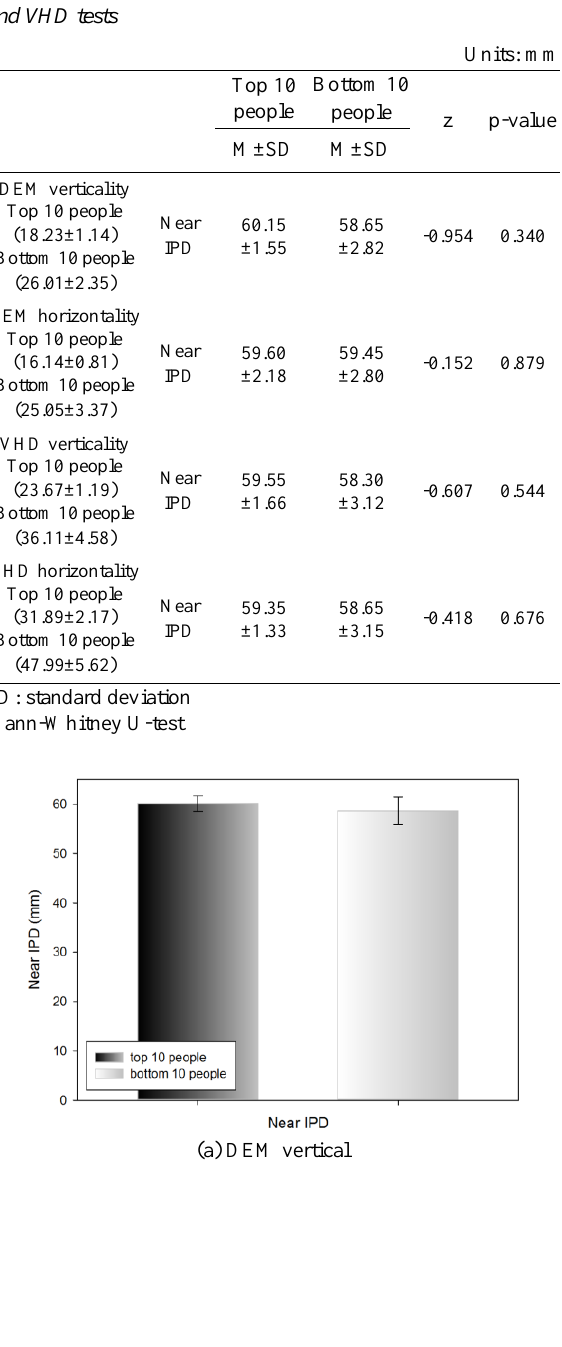
Near IPD of the top 10 and bottom 10 people in the DEM